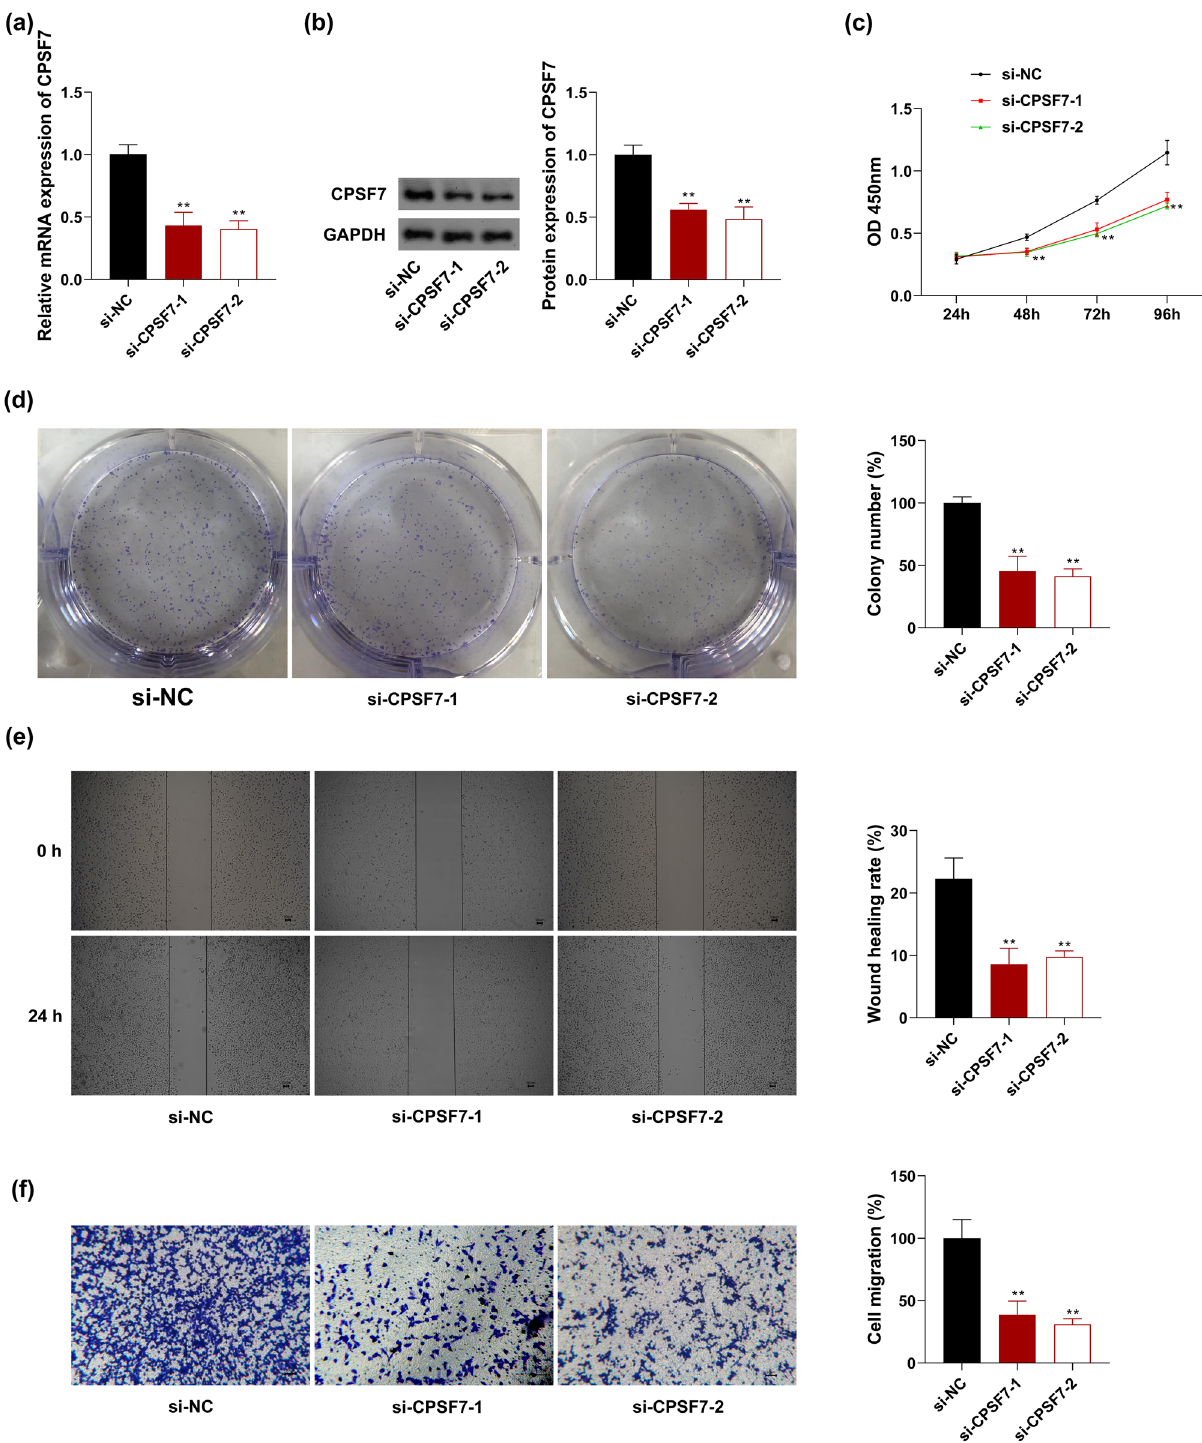
Figure A1: si - CPSF7 was e ff ective inA549 cells. ( a ) RT - qPCRwas used to detect the mRNA expression ofCPSF7. ( b ) Western blotting was used to detect the protein expression of CPSF7. ( c ) Cell viability detected by CCK - 8. ( d ) Colony number was detected by colony formation assay. ( e ) Cell migration rate was detected by wound healing assay ( scale bar = 50µm ) . ( f ) Invasion rate was detected by Transwell assay ( scale bar = 50µm ) . A549 cells were stably transfected with si - CPSF7 - 1 or si - CPSF7 - 2 . Each experiment was repeated 3 times ( n = 3 ) . ** P < 0.01 vs si -